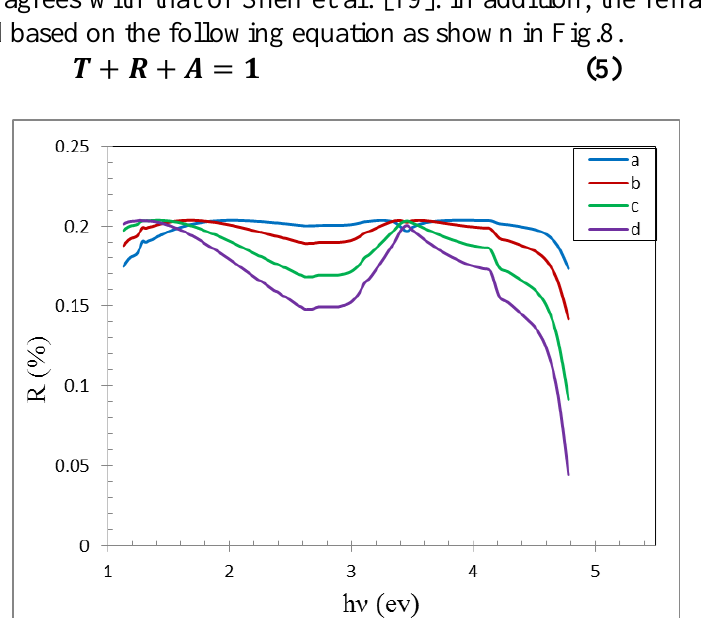
Fig.8: The reflectivity as a function of photon energy of glass for different doping concentrations of graphene oxide thin films ((a) 2%, (b) 4%, (c) 6%, (d) 8%